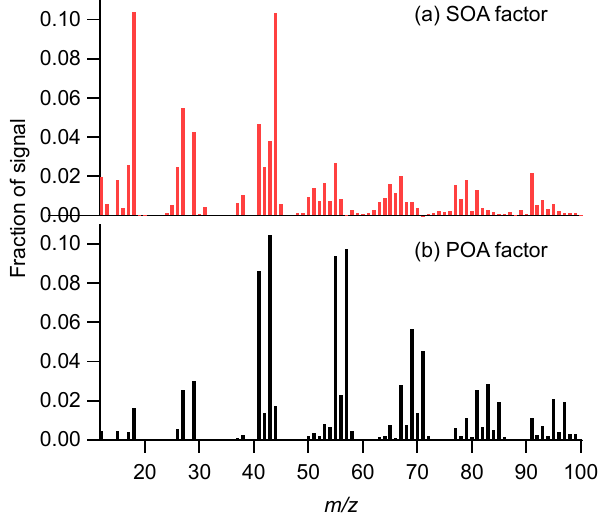
Figure 4. Mass spectra of the PMF factors for (a) SOA and (b) POA for the experiment shown in Fig. 1. The POA factor is dominated by reduced ions C x H y . m/z 44 is the largest ion in the SOA mass spectrum and m/z 43 is the largest ion in the POA mass spectrum.